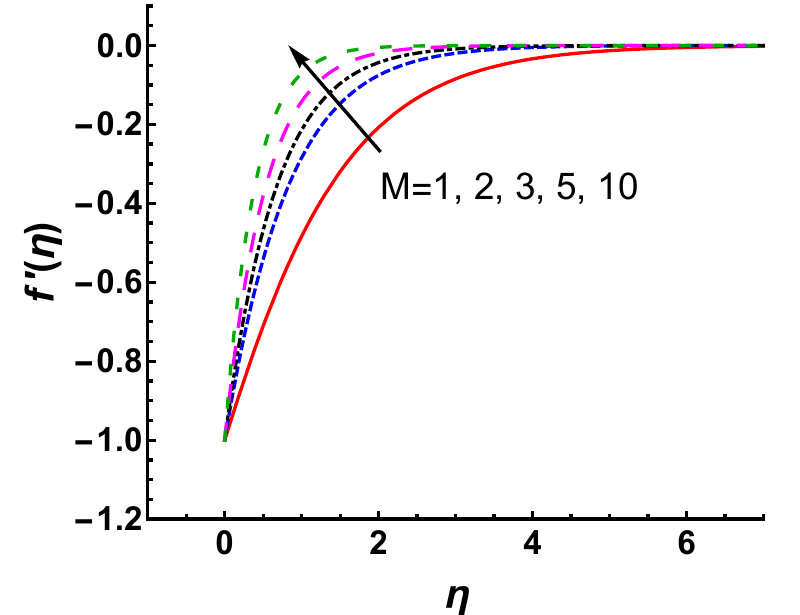
Figure 8. Velocity profile f (cid:48) ( η ) for different values of M with Pr = 0.71, γ = 1 and s =